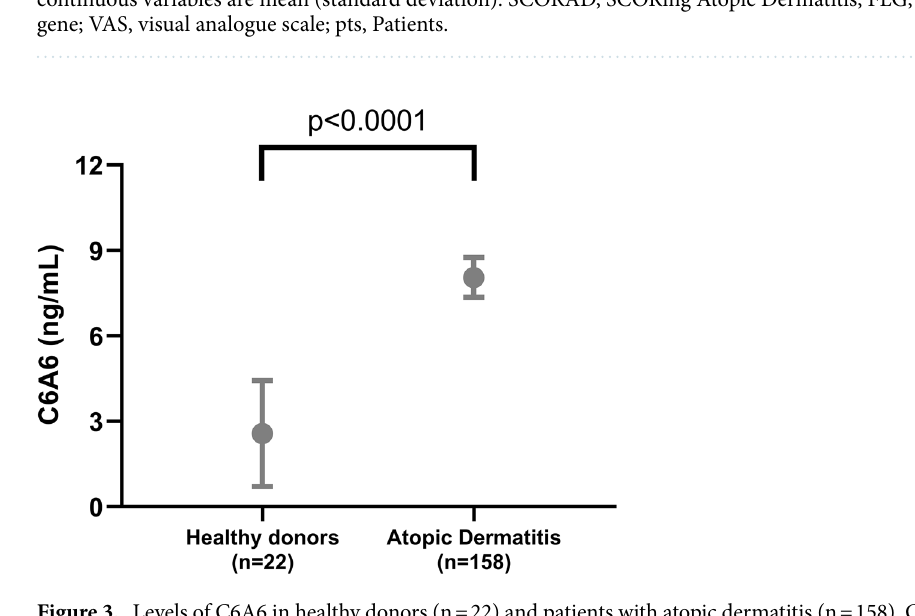
Figure 3. Levels of C6A6 in healthy donors (n = 22) and patients with atopic dermatitis (n = 158). C6A6 levels in healthy donors and patients with atopic dermatitis. Mean with 95% confidence interval. Data was analyzed using an ANCOVA corrected for age. Data are depicted as mean ±